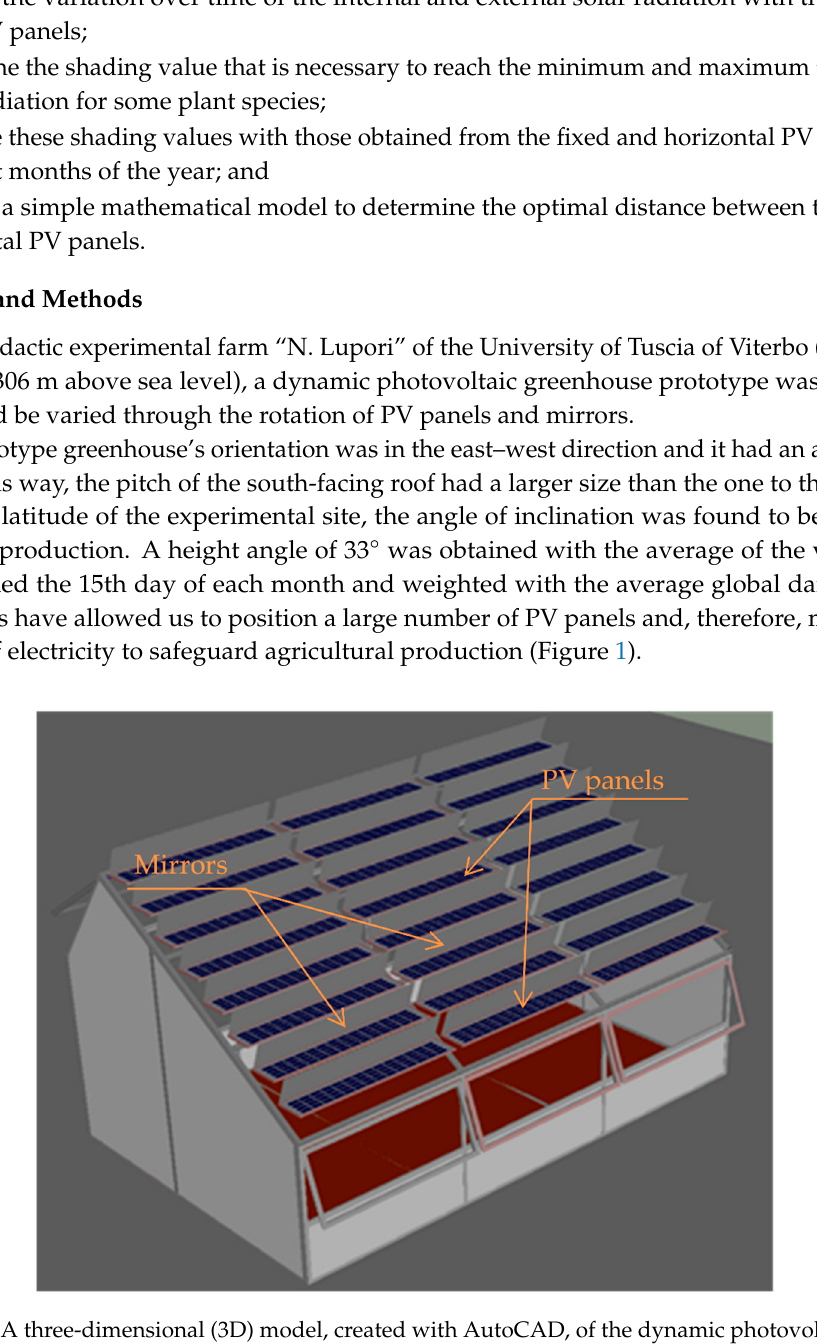
Figure 1. A three-dimensional (3D) model, created with AutoCAD, of the dynamic photovoltaic (PV) greenhouse prototype in which the PV panels and mirrors are visible.